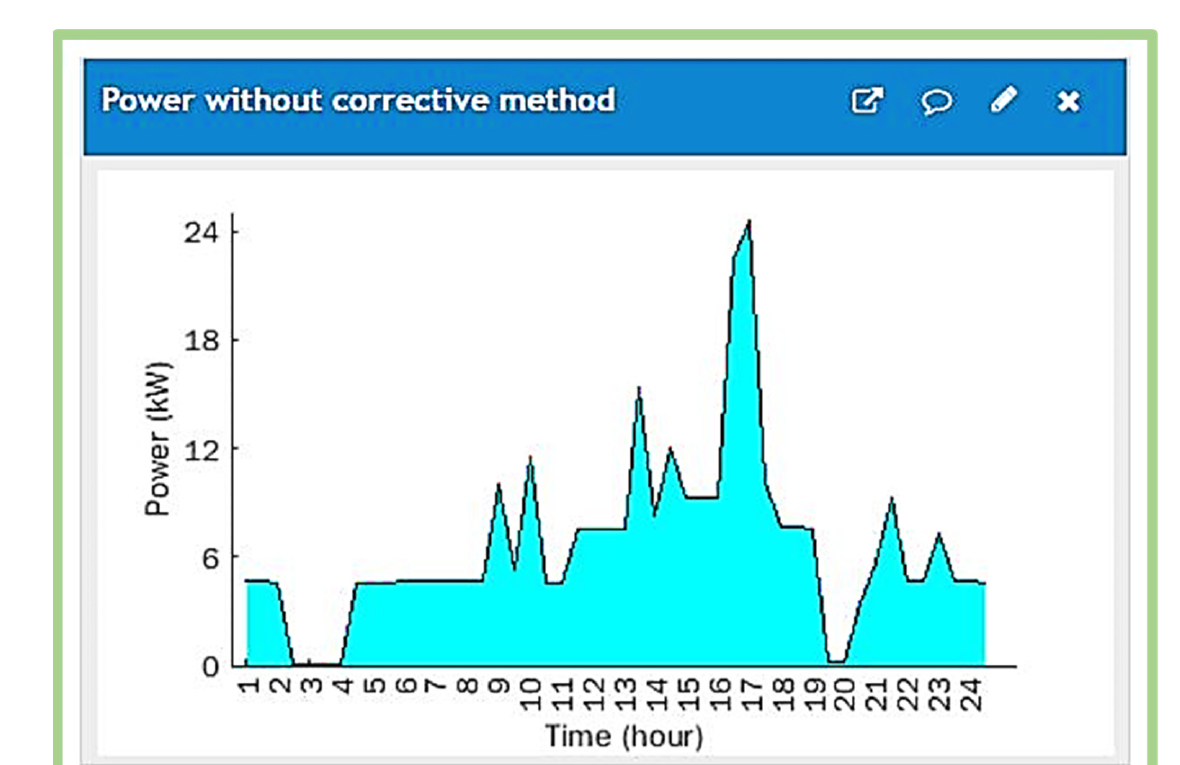
Figure 10. Power GUI of suggested EMS without the corrective method.